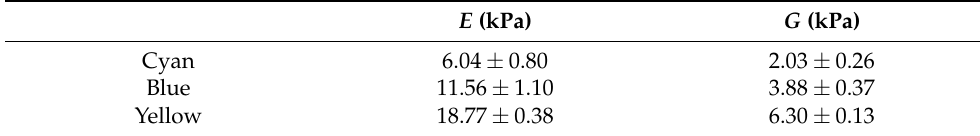
Table 1. Measured Young’s modulus by indenter compression on silicone